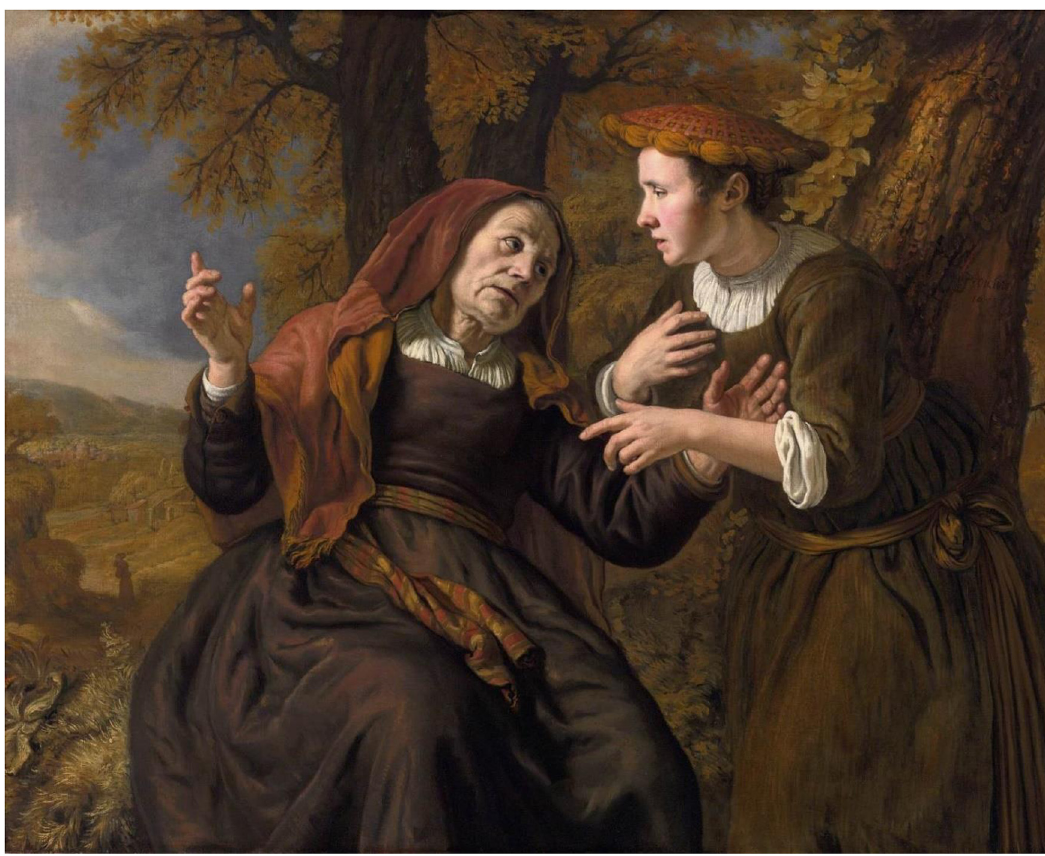
Figure 1: Jan Victors, Ruth swearing her allegiance to Naomi ,